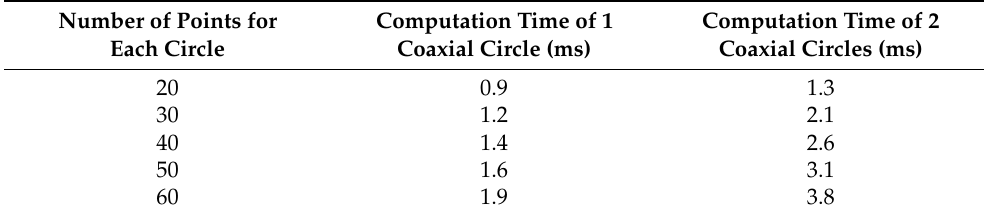
Table 3. This is a table of the relationship between the computation time and the number of points for spatial structure recovery.